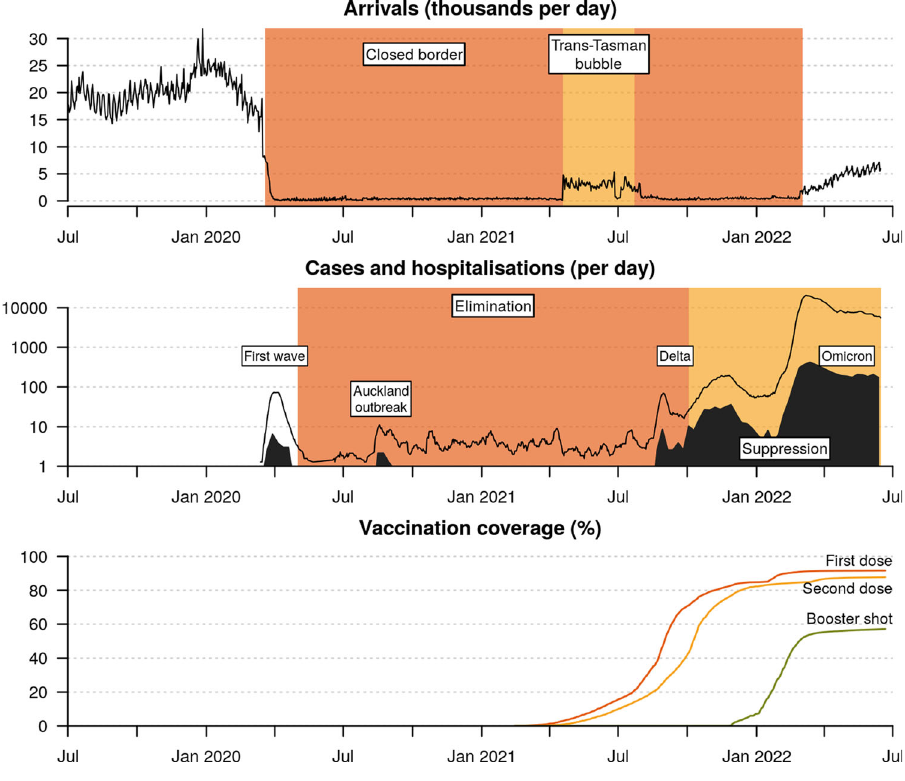
Fig. 1 | Timeline of the New Zealand COVID-19 pandemic. Top: International arrivalsperday. Middle: Dailycases(blackline)areaveragedacrossa1-weekperiod, and includecases inboth MIQ (managed isolation and quarantine)facilities aswell as the community, while daily hospitalisations ( fi lled curve) are averaged across weekly reports and describe cases hospitalised due to COVID-19. Bottom: